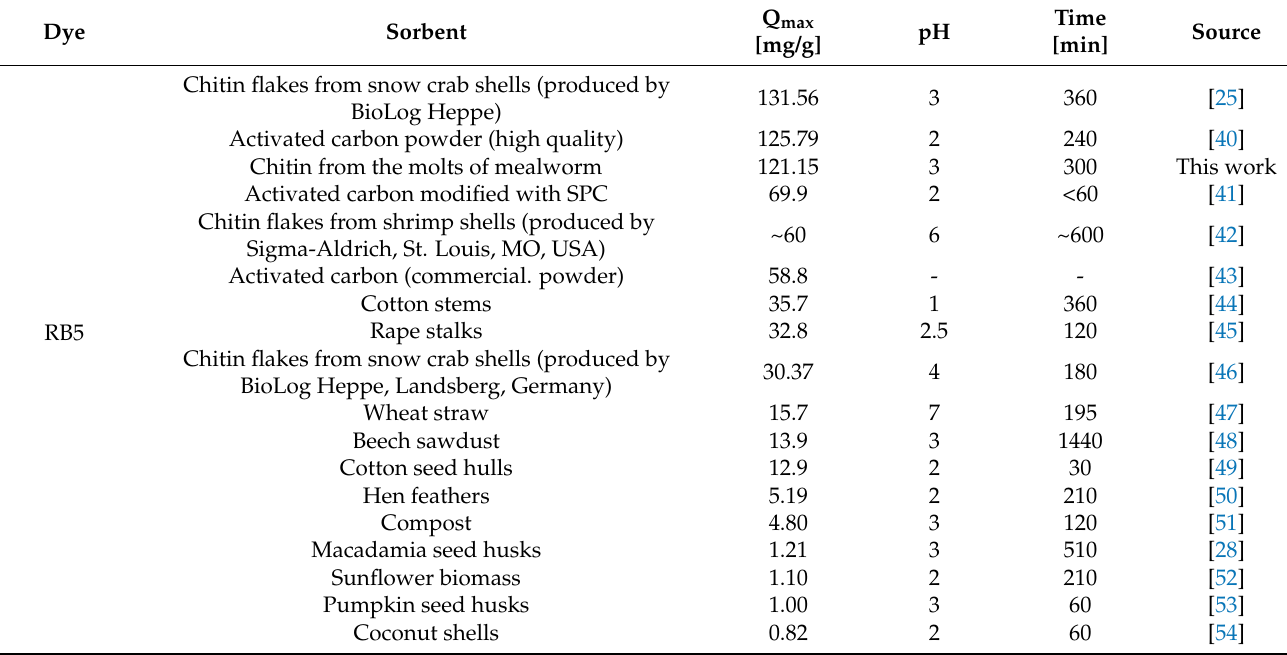
Table 5. Comparison of the sorption capacity of different sorbents in relation to RB5, RY84, BV10, and